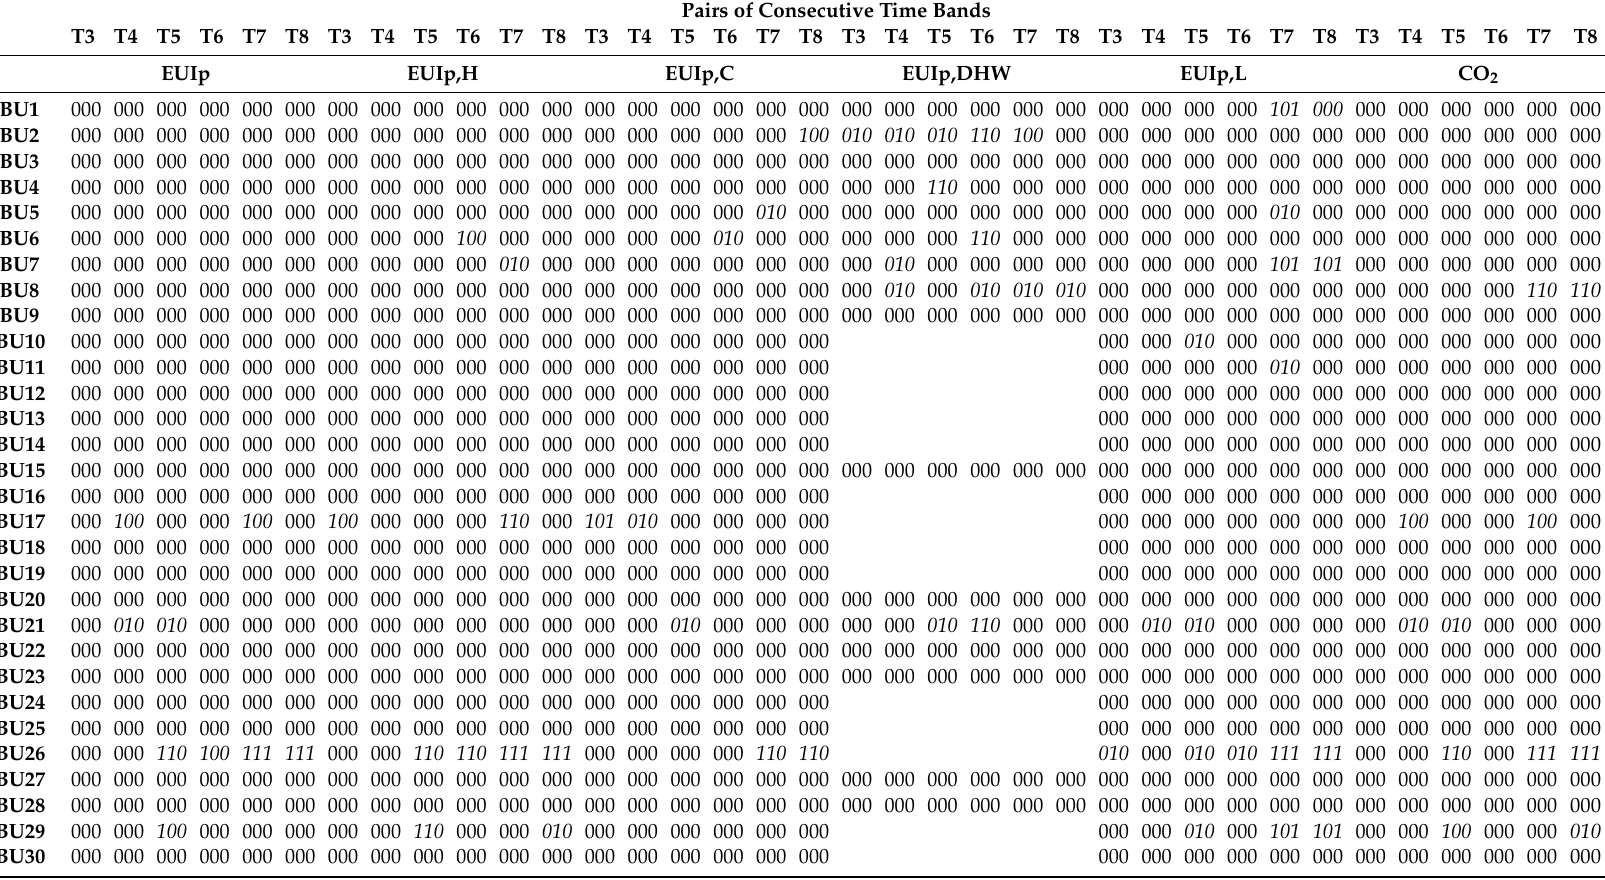
Table 9. Failures coding (F-codes) for primary energy uses and CO 2 intensities, for the di ff erent building uses in the NR Dbase. Pairs of Consecutive Time